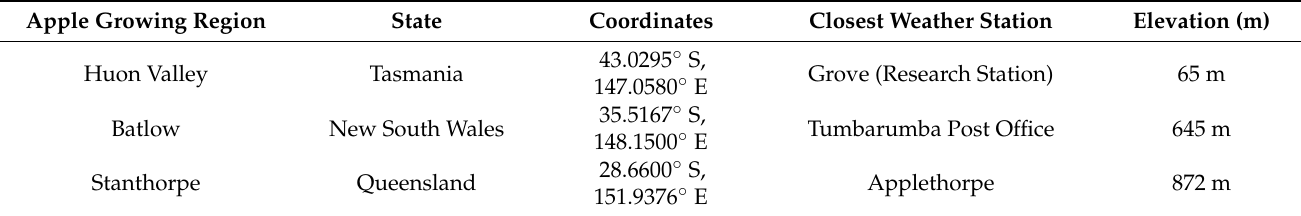
Table 1. Apple growing region geographical